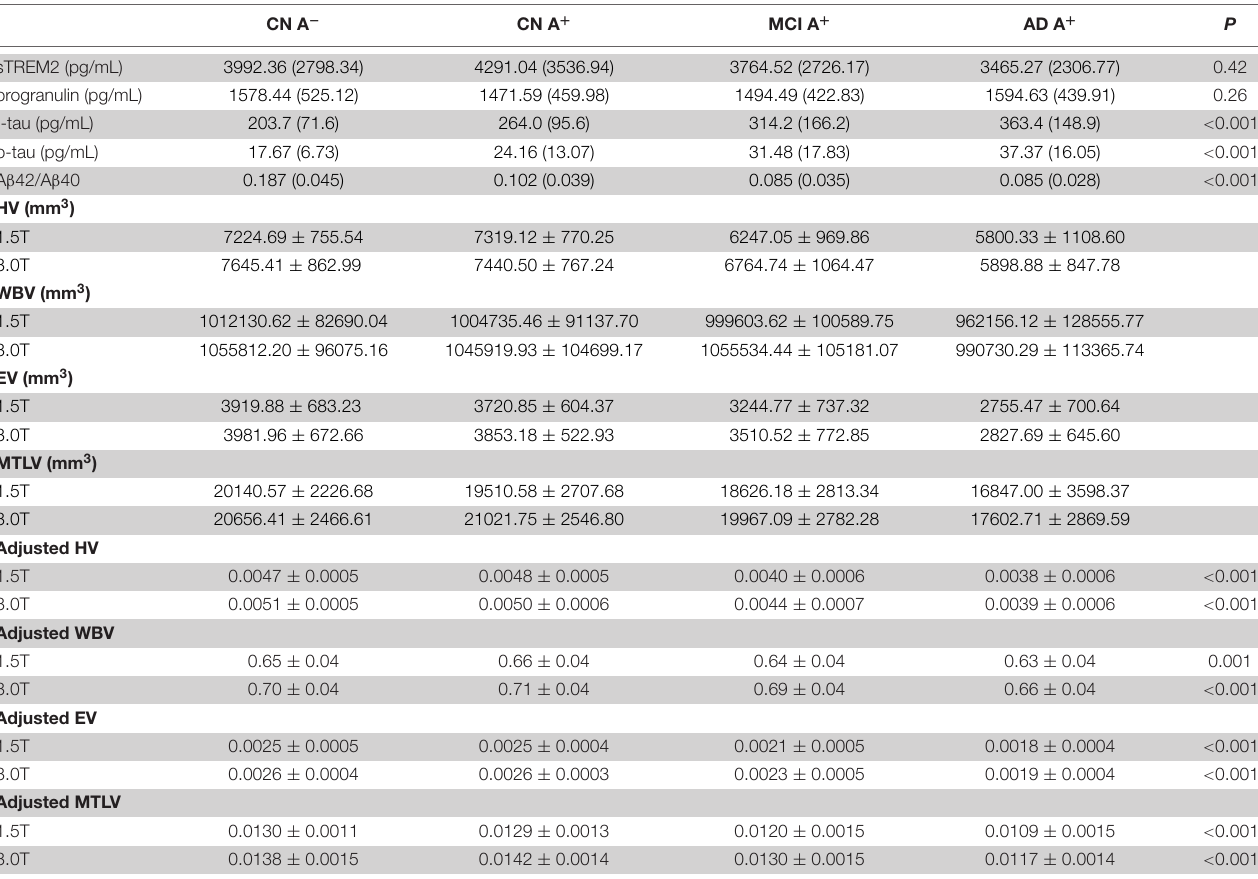
TABLE 2 | Baseline CSF sTREM2, progranulin, p-tau, t-tau concentration, A β 42/A β 40 ratio, and adjusted brain volume of CN group with amyloid-negative, CN, MCI, and AD groups with